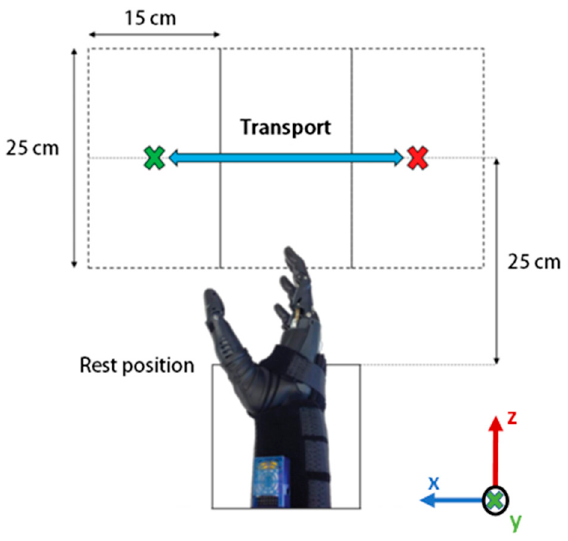
Figure 4. Top view of the classification performance assessment workspace. The object is placed in the centre of the left cordon and is transported towards the right cordon using a specific grasp pattern, and vice versa. The hand starts and ends at the rest position.